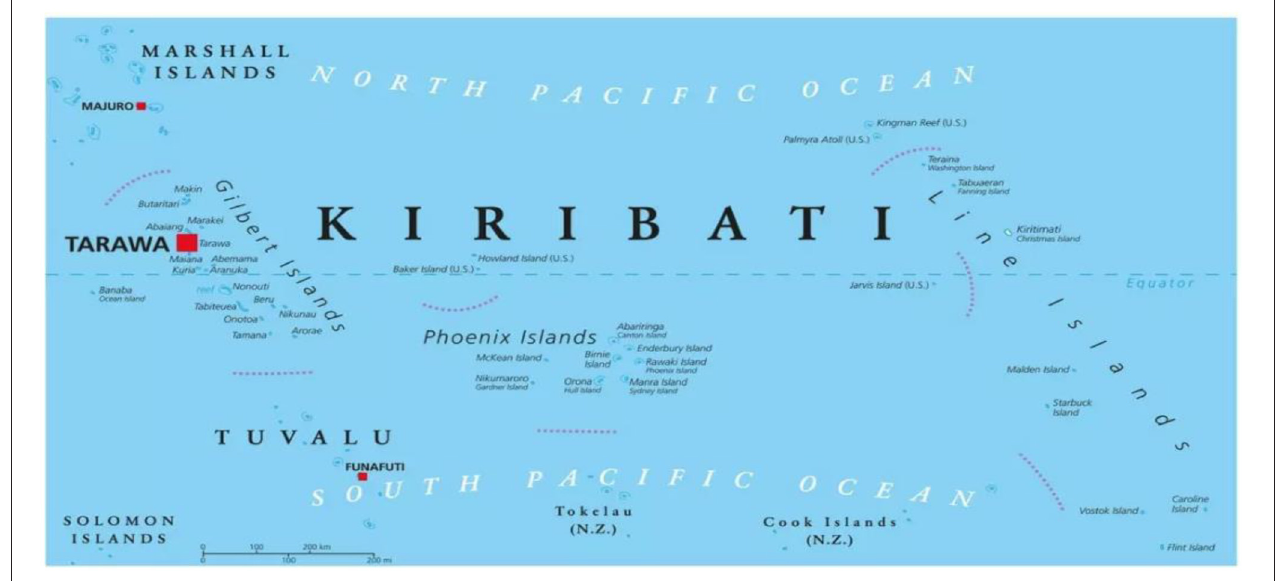
FIGURE 1 | Map of Kiribati Islands